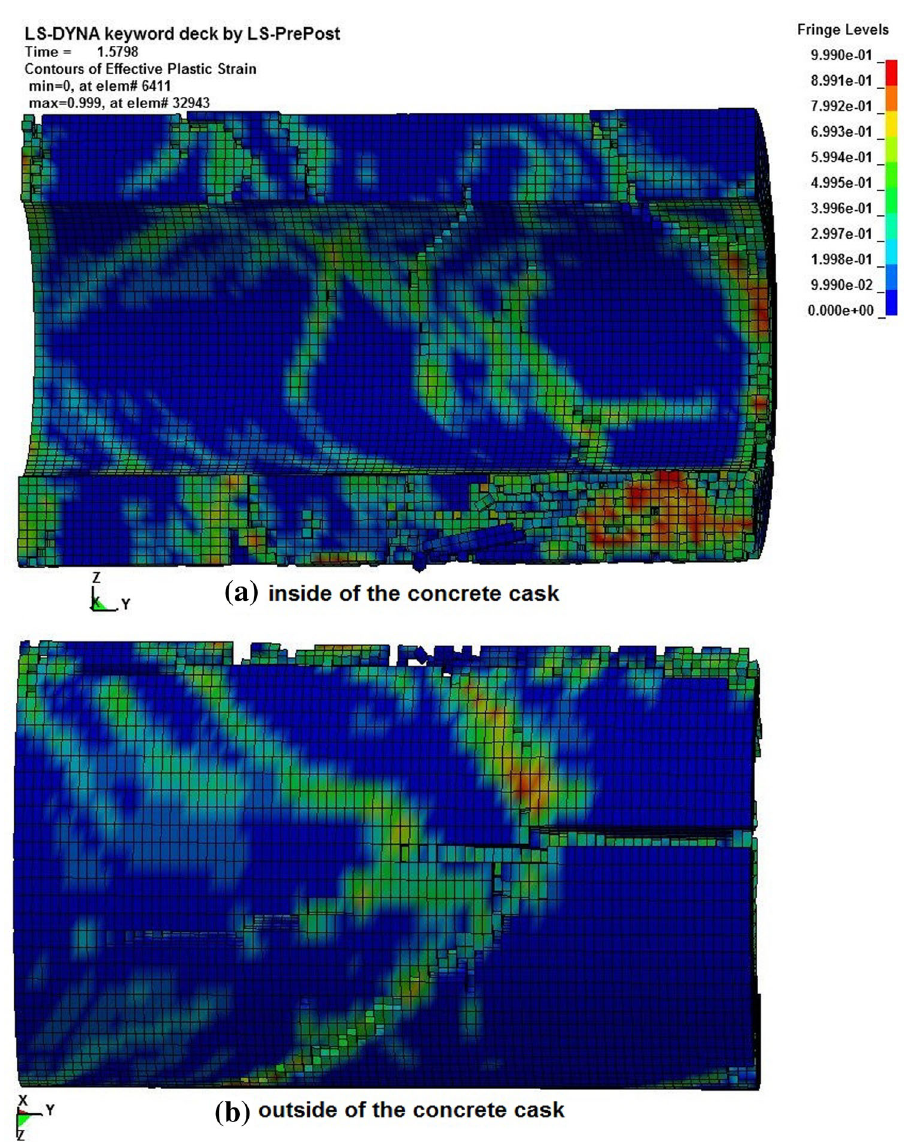
Fig. 22 Maximum brittle and ductile damage contours for the concrete